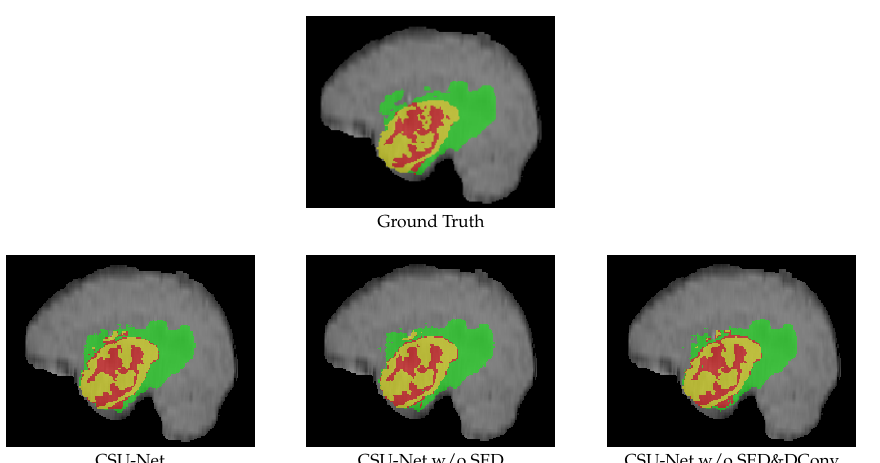
Figure 7. The visible MRI brain tumour segmentation results. Green, yellow and red represent the WT, ET and TC. ROW-1: Ground Truth(GT). ROW-2: Prediction